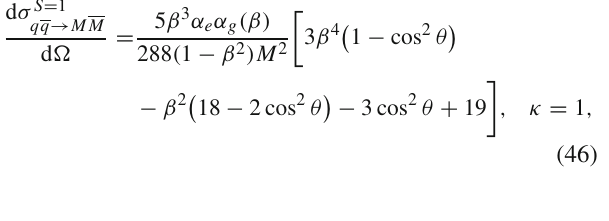
Fig. 19 Totalcrosssectionforthepairproductionofspin-1monopoles via the DY process, as a function of the monopole mass M for different √ s qq = 4 TeV values of κ at